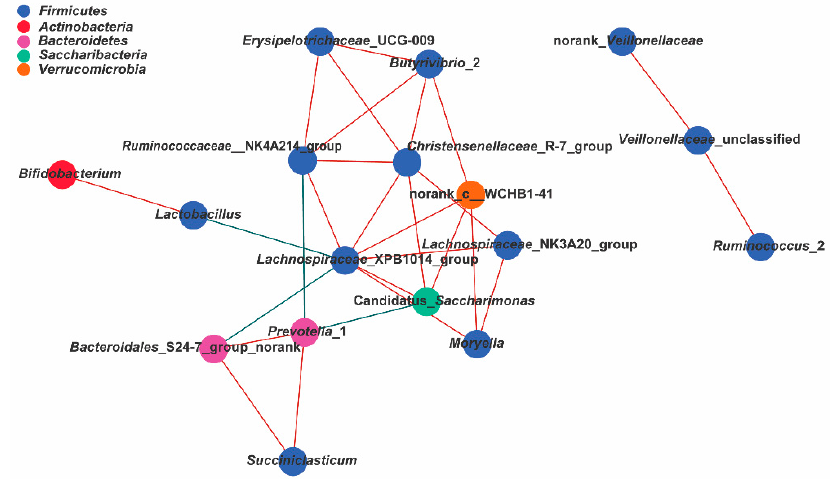
Figure 7. Correlation analysis of bacterial genera was visualized by Cytoscape version 3.6.1, wherein nodes represent bacterial genera, and edges represent significant interactions among nodes (the absolute Spearman coefficients were above 0.55, p < 0.05). The node color corresponds to the phylum taxonomic classification. The edge color represents positive (red) and negative (green) correlations.